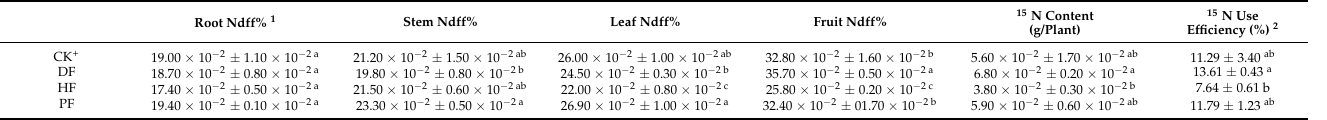
Table 3. N use efficiency under different fertilization